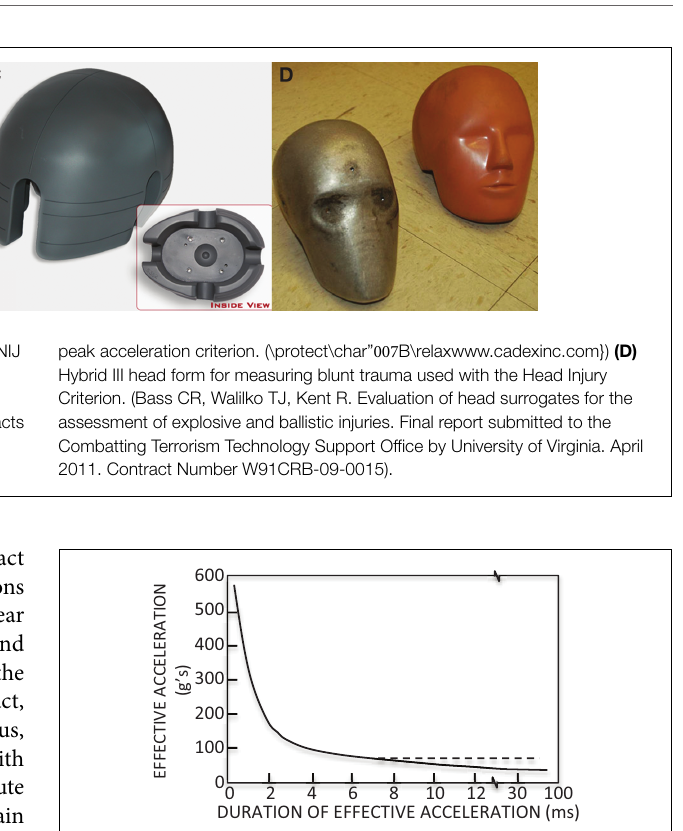
FIGURE 2 | Wayne State Tolerance Curve (WSTC) . The WSTC predicts injury based upon the maximum acceleration over a given duration that can be tolerated without leading to a skull fracture. It was the first head injury criterion based upon biomechanical research